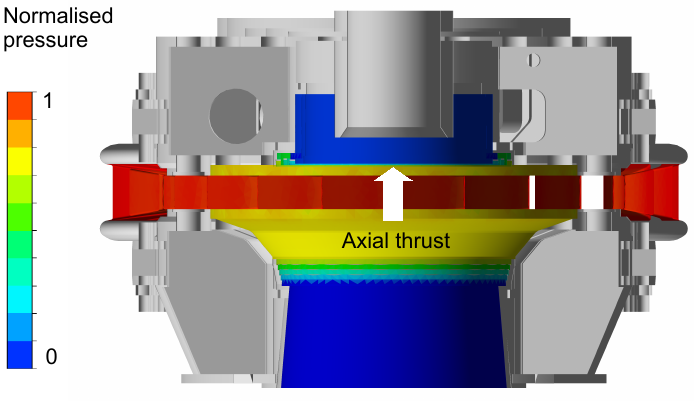
Figure 15. Fluid pressure mapping on the structural